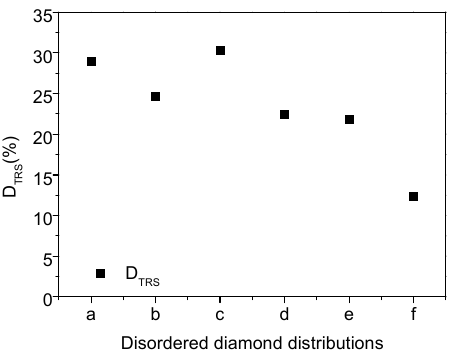
Figure A2. Disorderly distribution VS reduce rate of TRS.